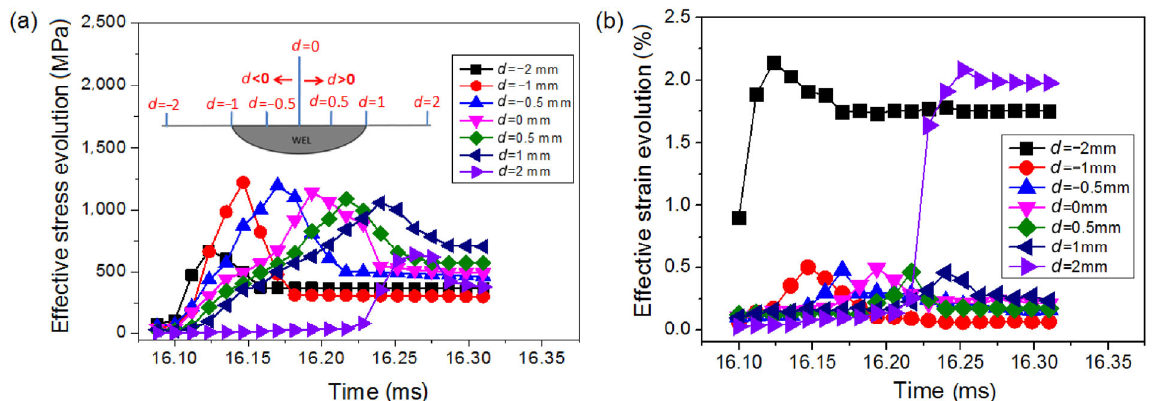
Fig. 5 Evolution history of (a) effective stress and (b) effective strain at seven selected positions around the WEL during wheel-rail rolling contact.